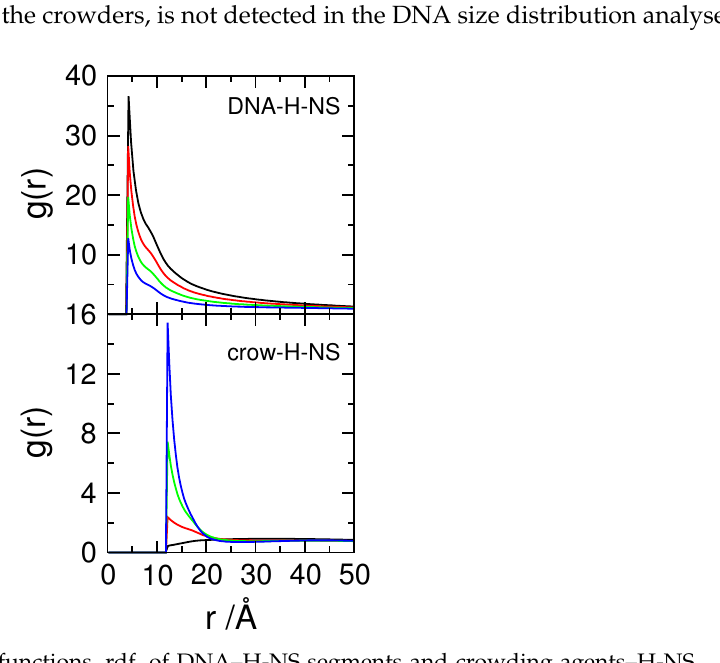
Figure 7. Radial distribution functions, rdf, of DNA–H-NS segments and crowding agents–H-NS segments, for systems with ε pp = 0 kT and crowding agents ( Φ crow = 0.06) with different charge density, σ crow = 0 (black), − 0.40 (red), − 0.80 (green) and − 1.20 (blue) e /nm 2 .